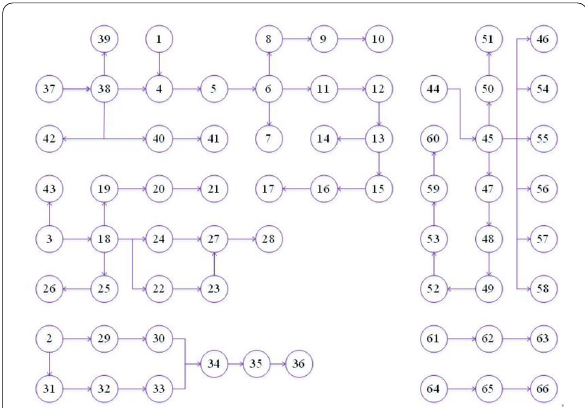
Figure 8 The precedence relationship of the